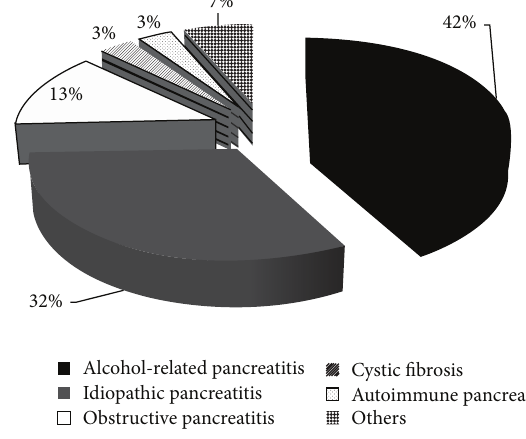
Figure 1: Etiology of chronic pancreatitis.